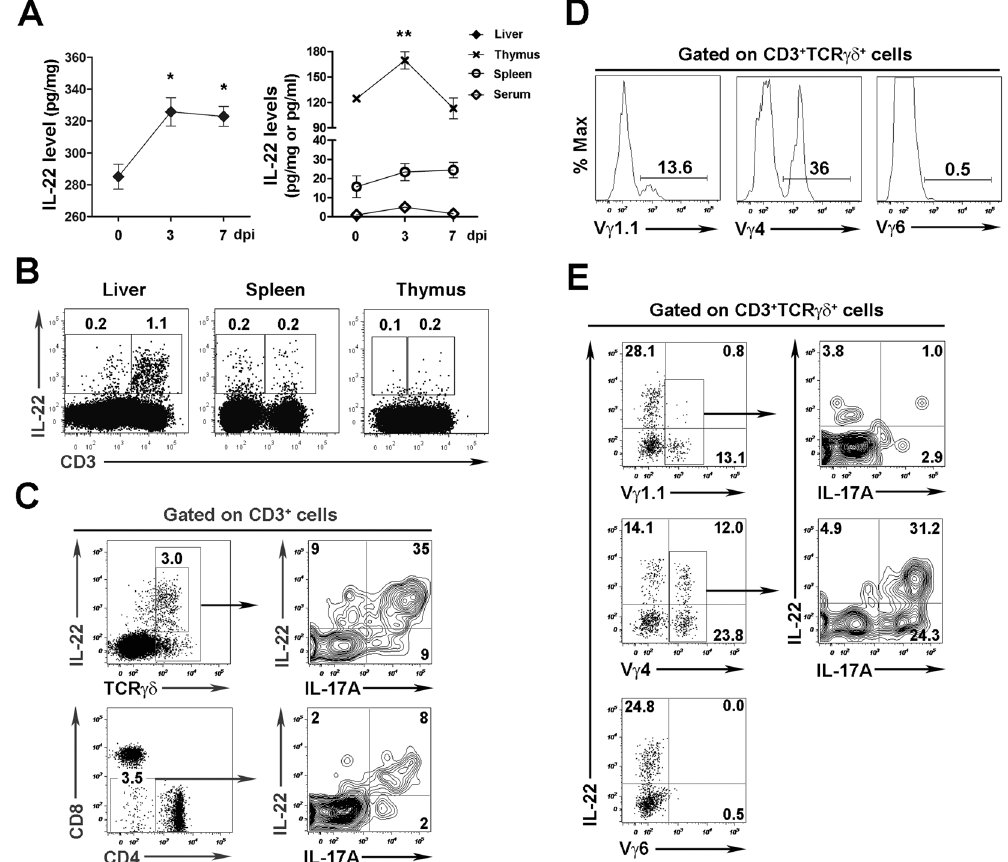
Figure 1. Viral infection triggers IL-22 production in γδ T cells. C57BL/6 (B6) mice were i . v . injected with LCMV Clone 13 (2 × 10 6 pfu/mouse) and then sacrificed at 0, 3, 7 dpi. ( A ) IL-22 levels in the liver, thymus, spleen, and serum were analyzed via ELISA. The results are expressed as the mean ± SEM ( n = 3–4 mice per time point). * p < 0.05; ** p < 0.01. ( B to E ) Introhepatic lymphocytes (IHLs) were isolated at 3 dpi